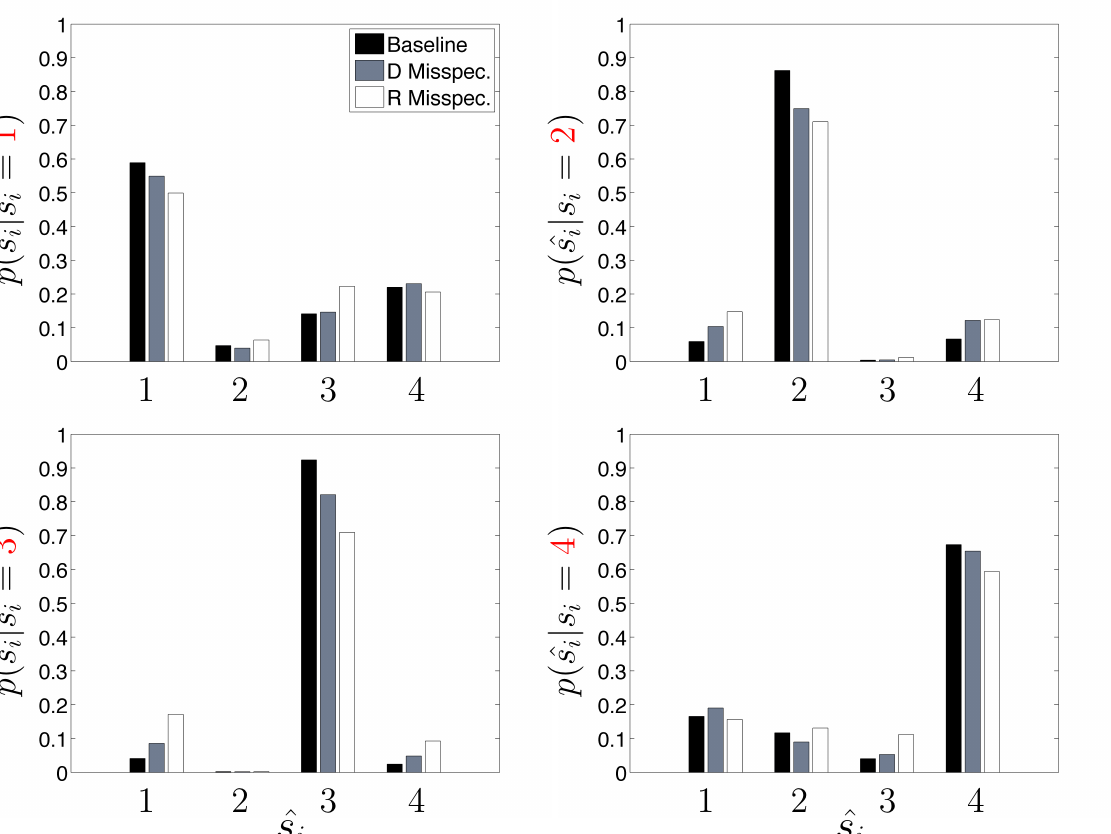
Figure 5. A finer breakdown of the HDP-SLDS performance as a function of the known underlying state for three different conditions studied in Table 1. The y-axis shows the empirical conditional probability of the state estimate ˆ s (x-axis) conditioned on the true i (known) underlying state s (the panels vary over the four truth states used by the simulated i data generating